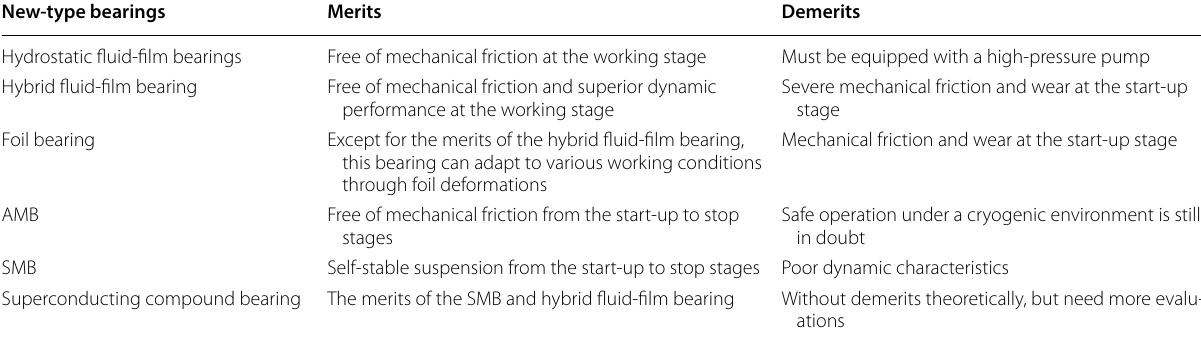
Table 3 Summary of merits and demerits of the new types of bearings New‑type bearings Merits Hydrostatic fluid-film